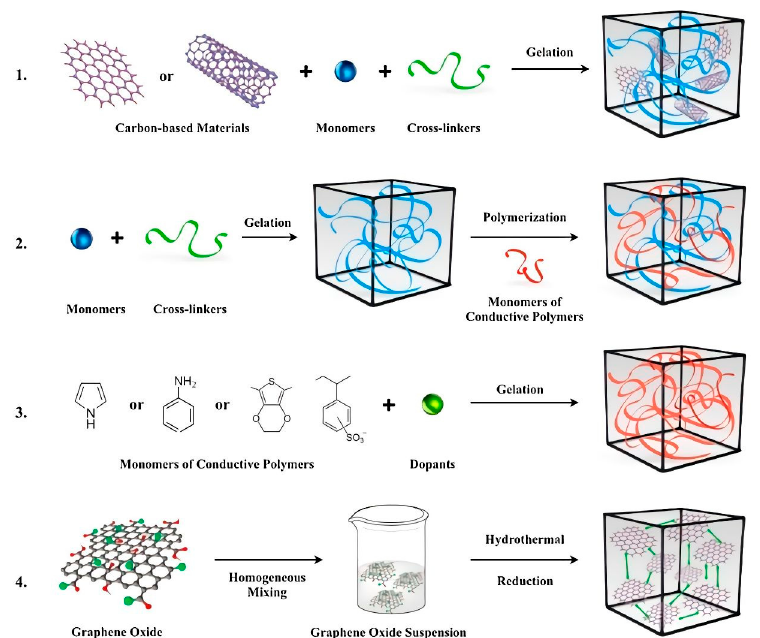
Figure 8. Four main approaches used to obtain ECAs: ( 1 ) hydrogel formation via a conductive filler suspension; ( 2 ) polymerization within a preformed hydrogel matrix; ( 3 ) cross-linking conductive polymers with dopant molecules; and ( 4 ) self-assembly of graphene hydrogel via supramolecular interactions. Reprinted with permission from Ref. [116].